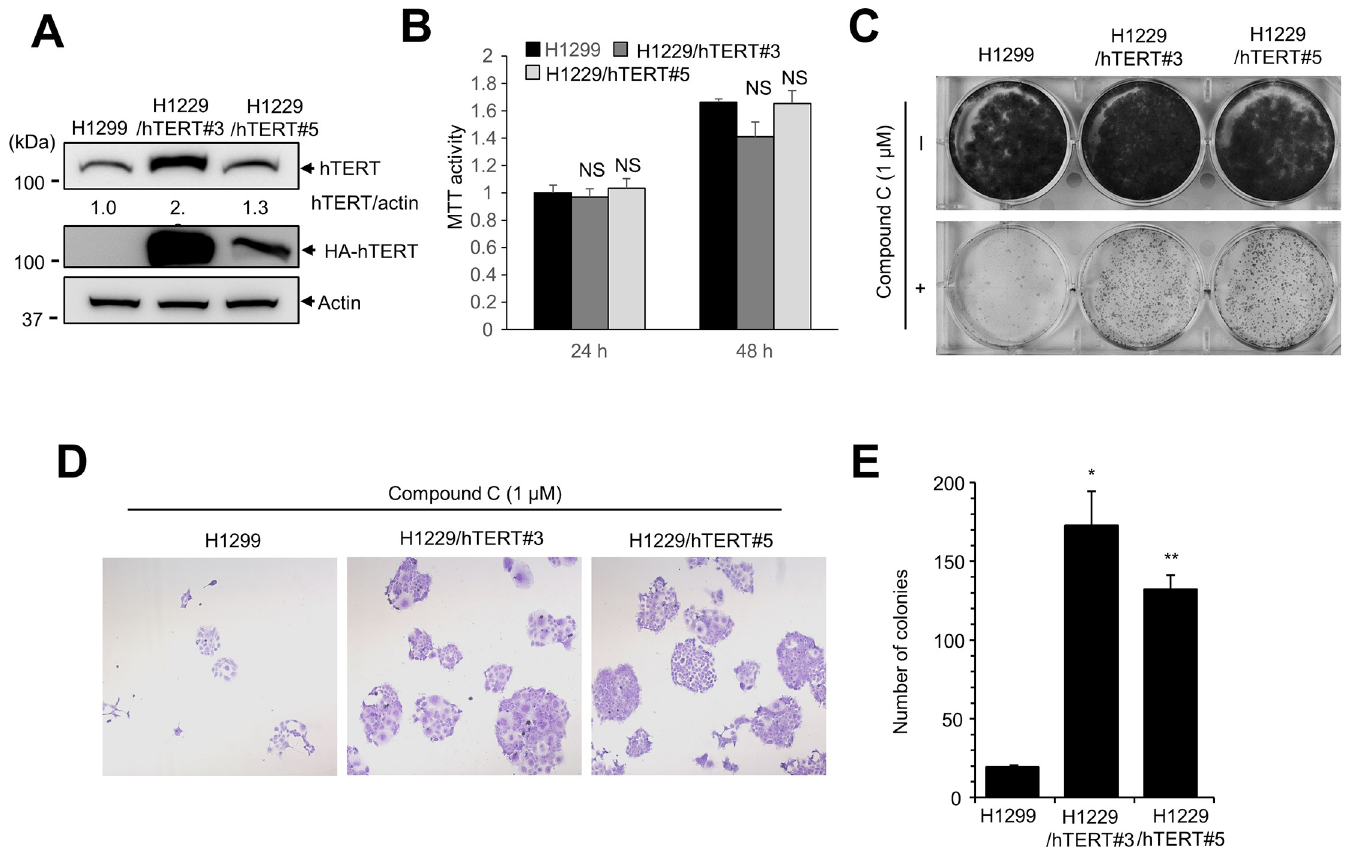
Fig 7. H1299 cells expressing hTERT are resistant to compound C treatment. ( A ) H1299 cells were transfected with plasmid encoding 3 × HA-hTERT to generate H1299 cells stably expressing hTERT (H1299/hTERT). Western blotting demonstrated that HA-hTERT was expressed in H1299/hTERT cells. Equal amounts of H1299 control and H1299/hTERT were subjected to western blotting with anti-hTERT antibody and anti-HA antibody. ( B ) MTT assay showed no significant difference between H1299 and H1299/hTERT. Equal number of cells (8,000 cell/well) were seeded in 24 well plates, and MTT assay were performed at the indicated times. H1299 vs. H1299/hTERT. NS, not significant. ( C ) Clonogenic assays were carried out to assess the effects of hTERT overexpression on cell proliferation. H1299/hTERT cells were treated with compound C (1 μ M) for 10 days before fixation and staining with crystal violet. ( D ) Light microscopy (200 × ) images of clonogenic assays. ( E ) The number of colonies was counted. H1299 vs. H1299/hTERT, � P < 0.01, �� P <